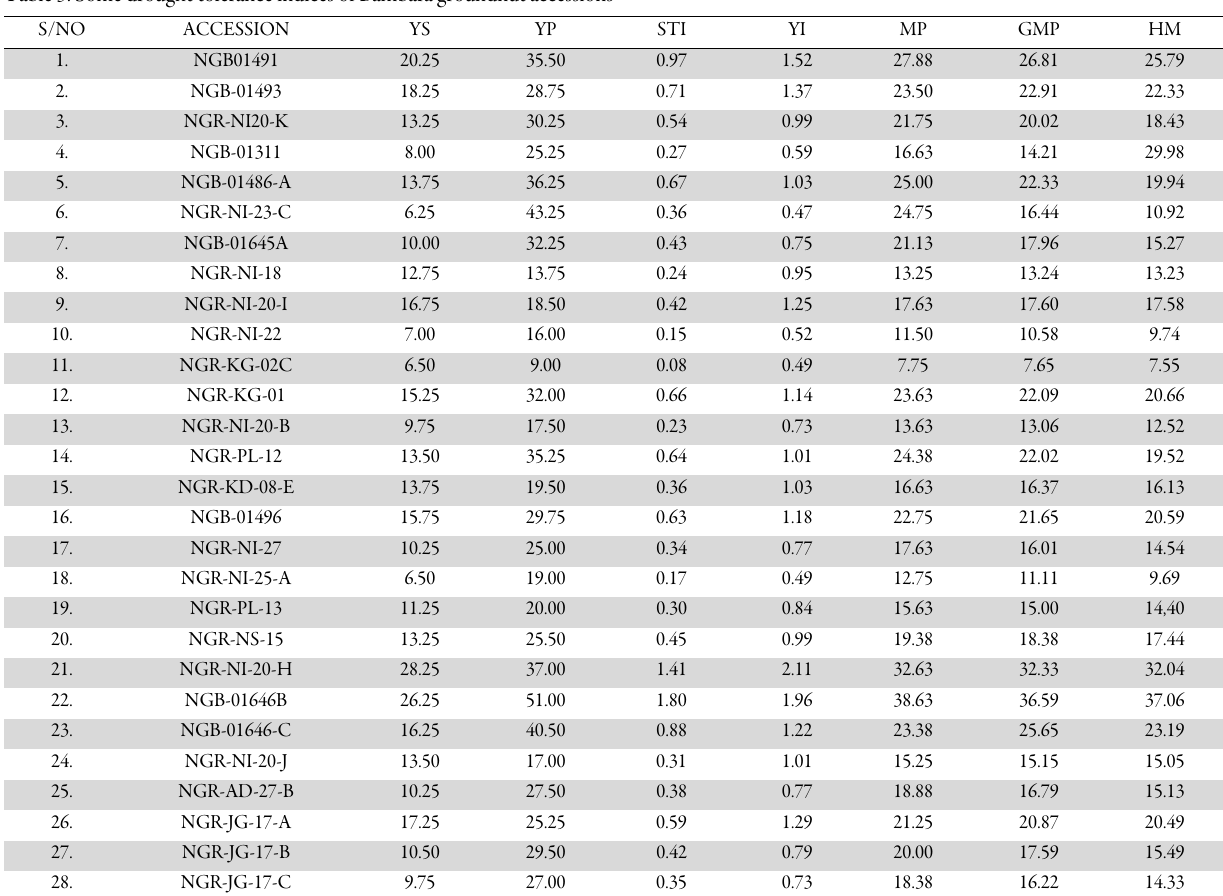
Table 3. Some drought tolerance indices of Bambara groundnut accessions